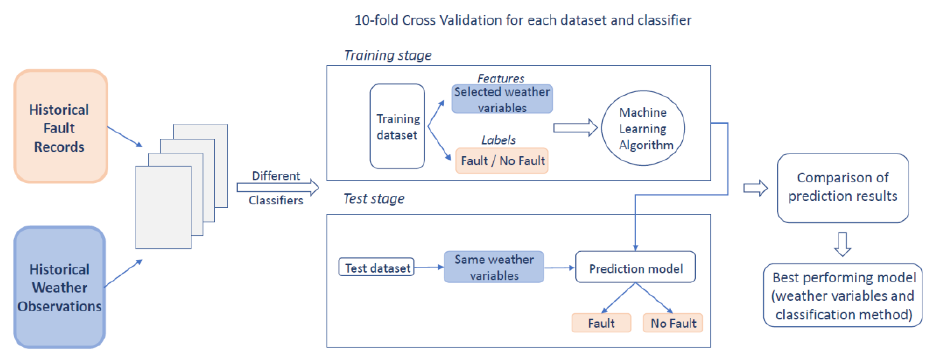
Figure 1. Data analysis